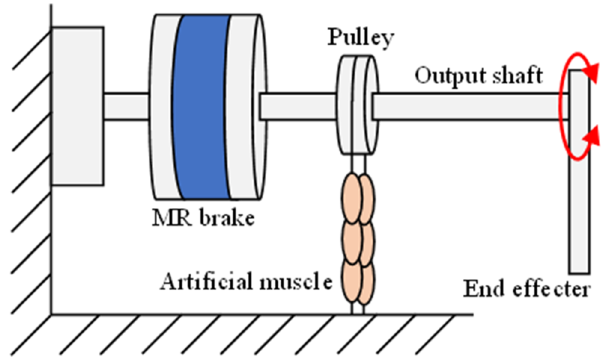
Figure 2. Operation principle of variable viscoelastic joint.